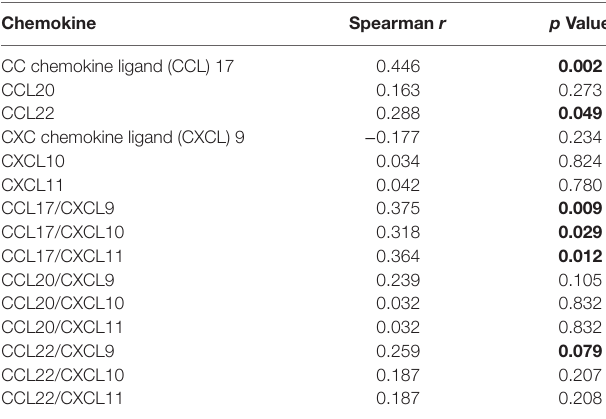
TaBle 2 | Two-tailed Spearman correlation of chemokines and T helper cell type (Th) 2/Th1 ratio to atopic dermatitis severity (oSCORAD) ( n = 41). chemokine spearman